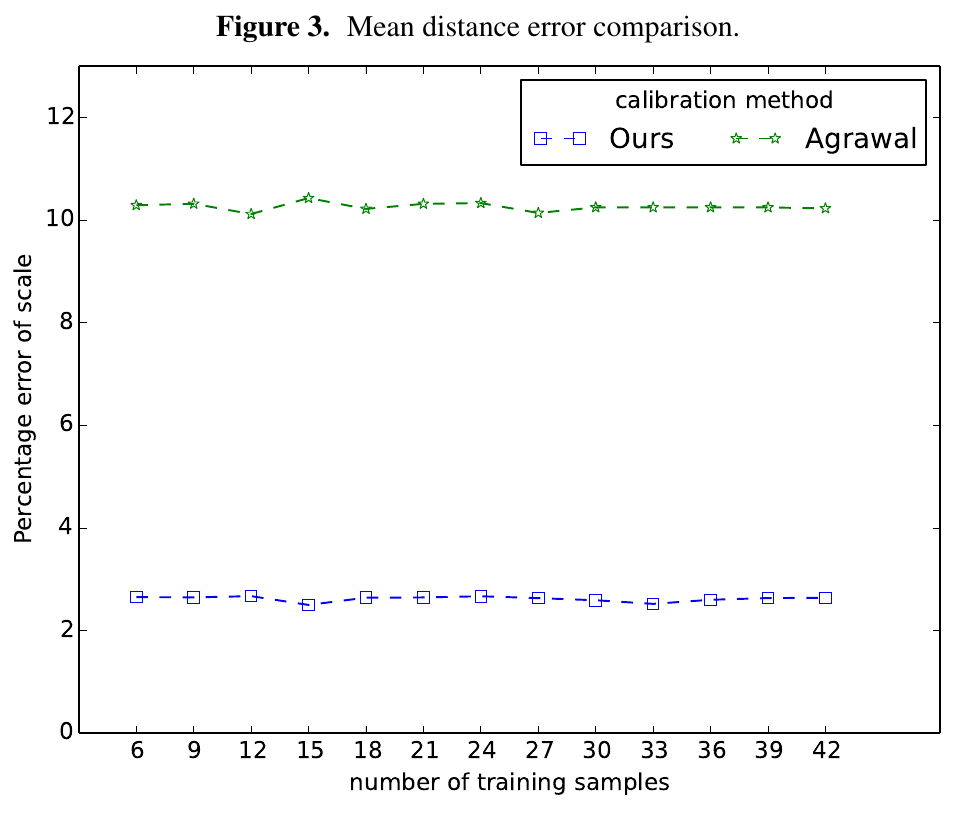
Figure 4. Scale error comparison with different number of training